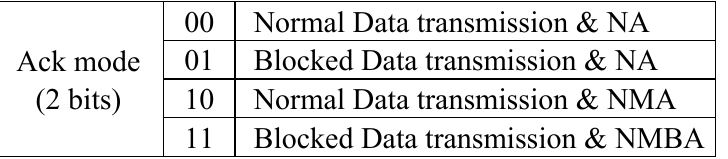
Table 4. Ack mode